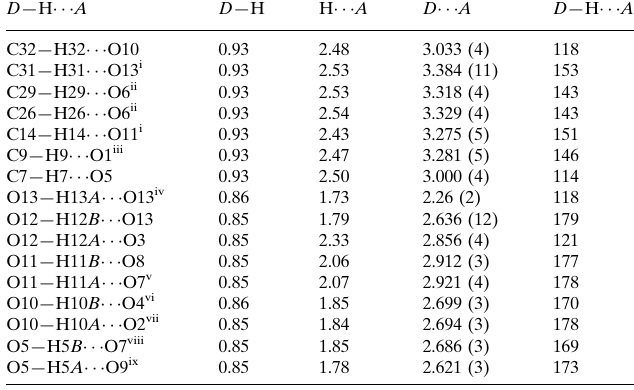
Hydrogen-bond geometry (A˚ , (cid:2) H N O )- 6 2 2 4